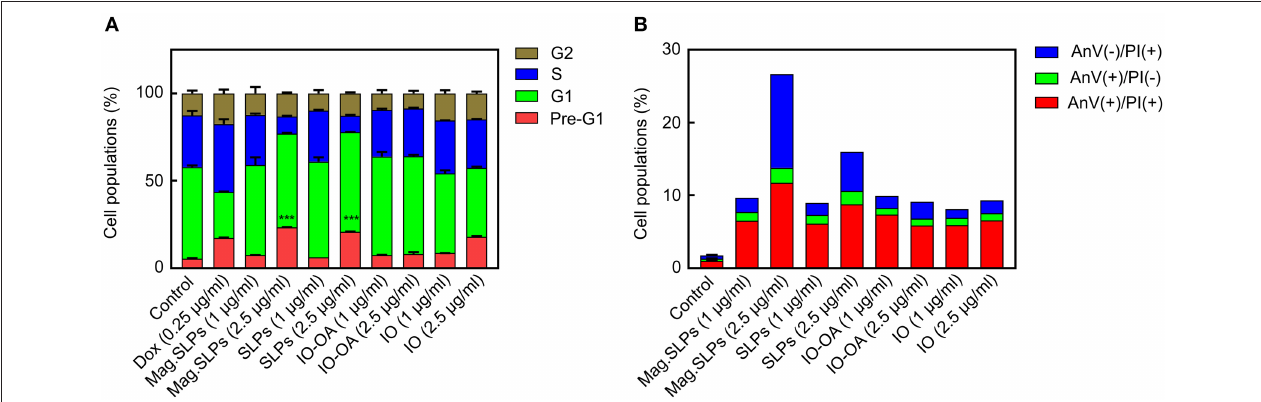
FIGURE 9 | Cell cycle arrest and cell death induction by mag.SLPs. (A) Dose-dependent impact of the mag.SLPs, SLPs, IO-OA, and IO on the distribution of Jurkat T-leukemia cells in different phases of the cell cycle determined by FACS analysis of propidium iodide (PI)-stained cells after 24h of continuous exposure. (B) Impact of the particles after 24h of incubation on the phosphatidylserine externalization in Jurkat T-leukemia cells measured by FACS analysis using FITC-labeled Annexin V and PI staining. Dox, doxorubicin (positive control). *** p ≤ 0.001 compared to control untreated